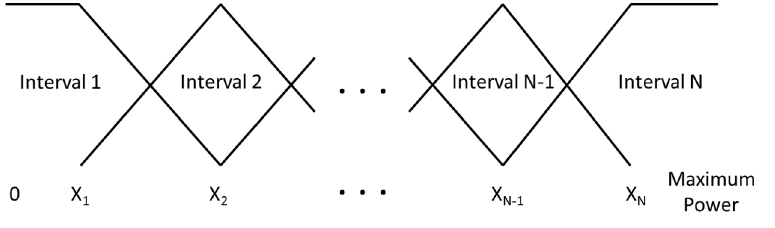
Figure 2. Dynamic fuzzy variable, adapted from